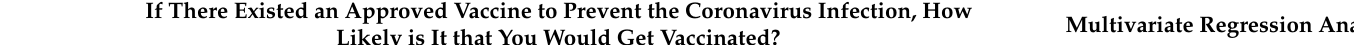
Table 1. Bivariate and Multivariate Analyses of Socio-Demographic Characteristics with Vaccine